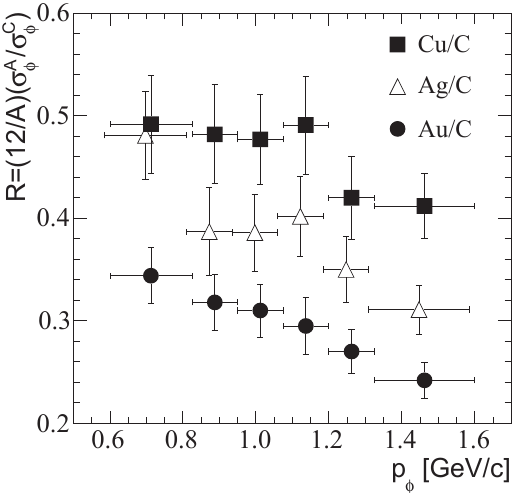
Fig. 4. Momentum dependence of the nuclear transparency ratio R , normalized to carbon, for Cu, Ag, and Au targets. The drawn error bars consider quadratically weighted statistical and systematic uncertainties. Further details in